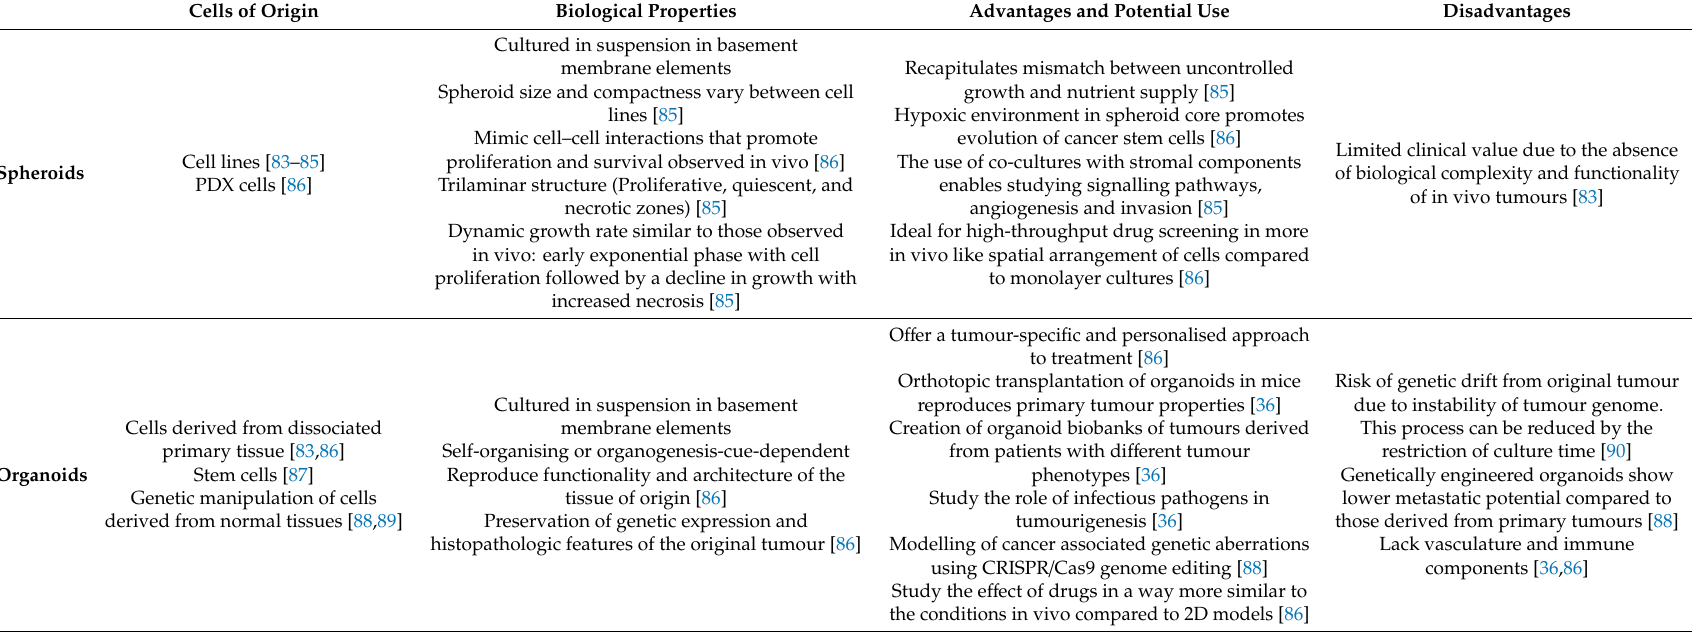
Table 1. Organoid and spheroid cultures o ff er advantages and disadvantages over each other, and the choice of a specific approach should be